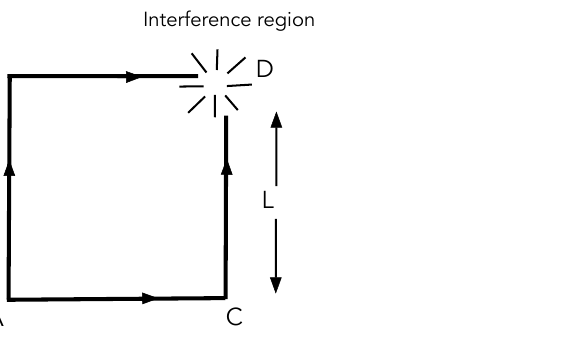
Figure 1. Scheme of the matter interferometry apparatus. A superposition of two wave packets is sent in point A towards B and C, respectively, where they are reflected, and then recombine in